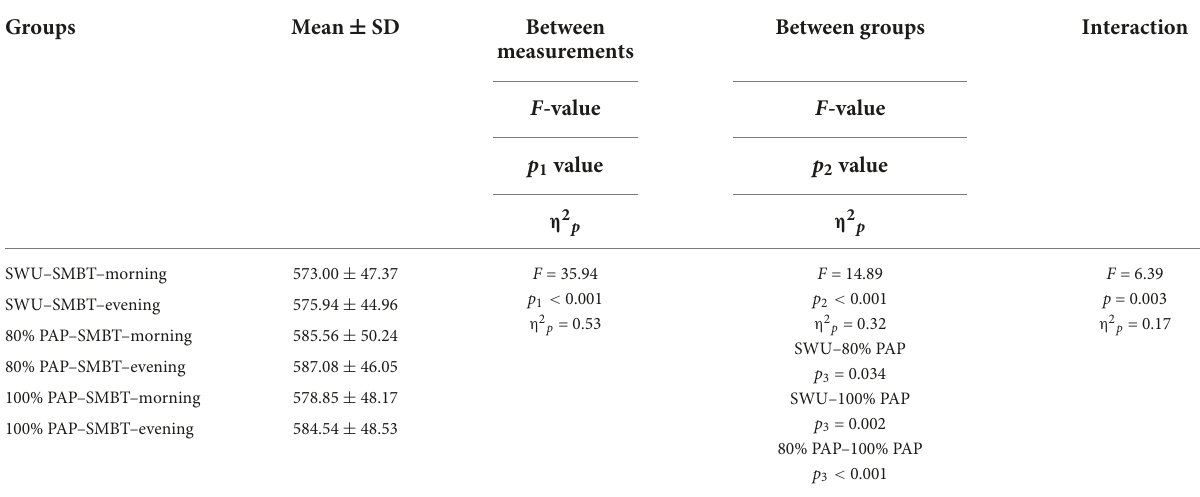
TABLE 3 Comparison of the measured values of SMBT.